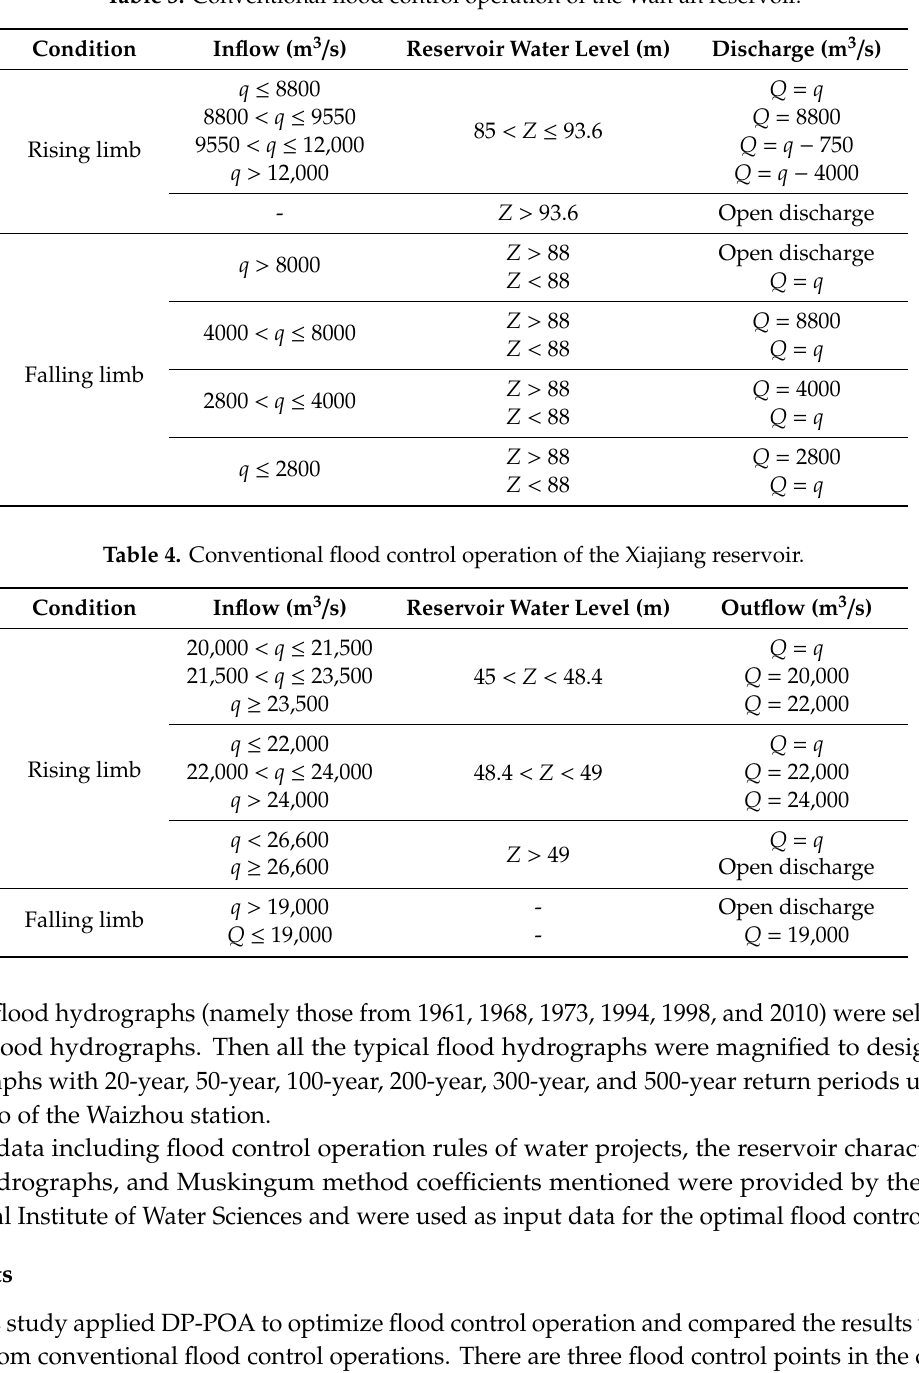
Table 3. Conventional flood control operation of the Wan’an reservoir.